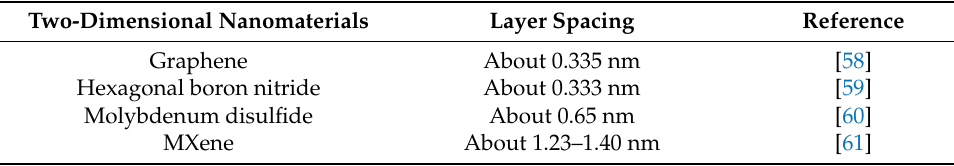
Table 1. Layer spacing of common two-dimensional